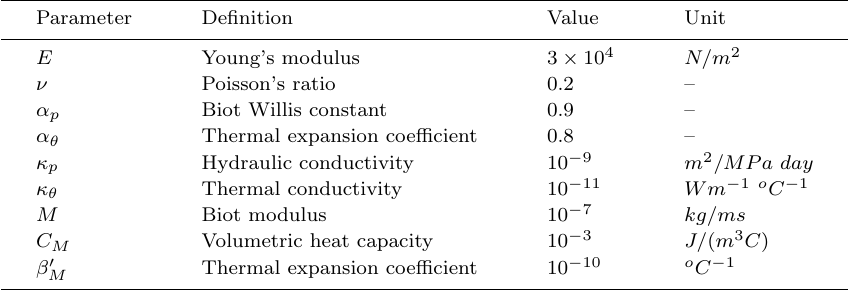
Table 5. Material parameters for the two dimensional footing problem.